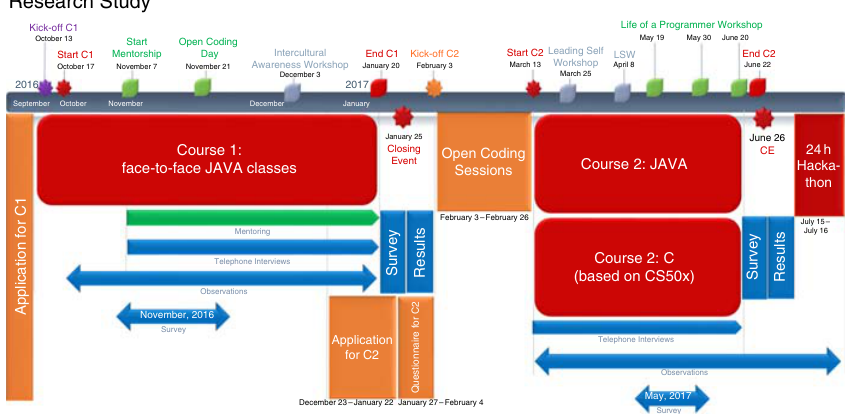
Figure 3. Time table of the